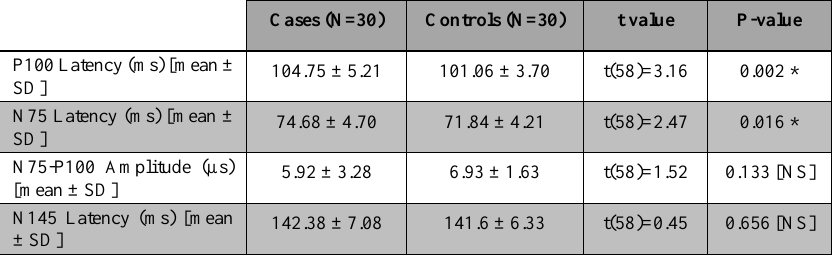
Table 10. Comparison of average N75-P100 amplitude and VEP wave latencies of both eyes (in µV) between cases and controls.